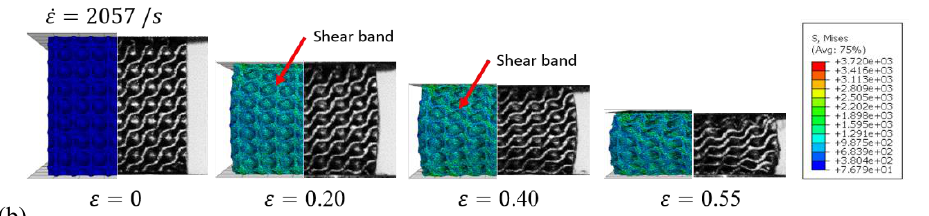
Fig. 7. Quantitative numerical and experimental results of SD TPMS (a) quasi-static and (b) dynamically loaded.